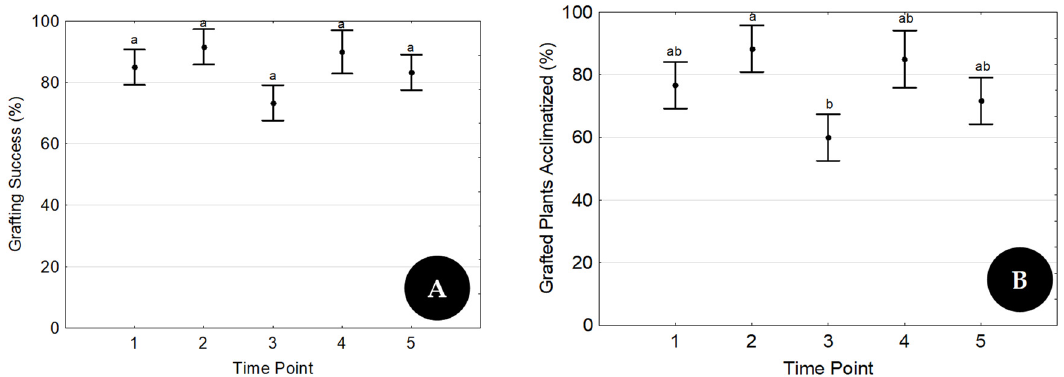
Figure 7. Grafting success ( A ) and percent of grafted plants acclimatized ( B ). High–low bars represent the confidence intervals (LSD 95%), and different letters refer to statistically significant differences among treatments for each parameter under evaluation ( p ≤ 0.05).